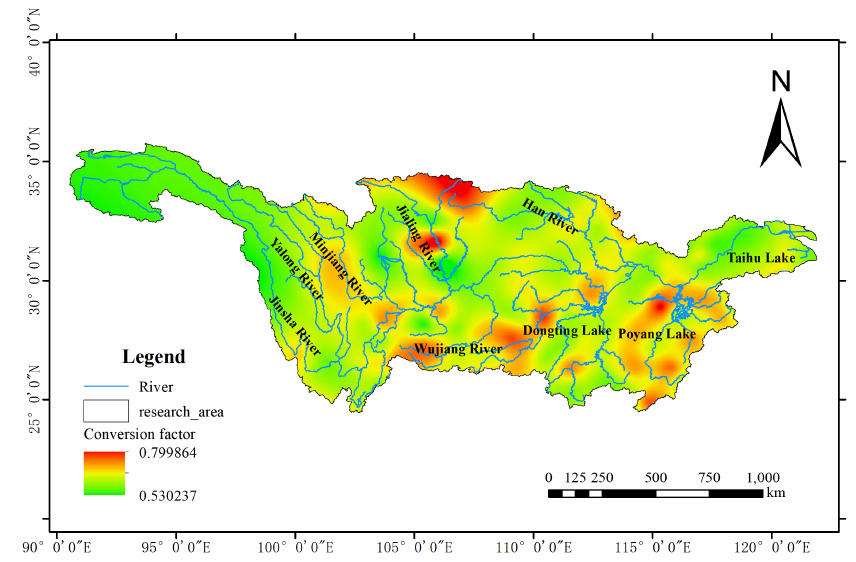
Figure 14. Spatial distribution of conversion coefficients for D20 and E601 pans in the Yangtze River Basin. Table 3. Results of multiple linear regressions between conversion coefficients and climate